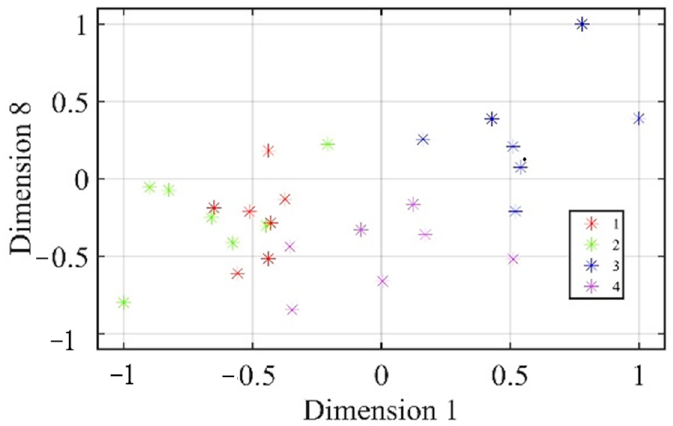
Figure 5. FCM algorithm in a 2D scatter plot.